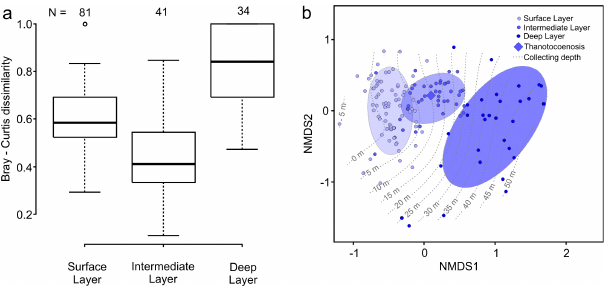
Fig. 4. (a) Quartile box plots of Bray–Curtis dissimilarities of the fossil and 156 recent gastropod assemblages. Assemblages from the Intermediate Layer habitats showed the significantly (F 2 , 153 = 52.44, P < 0 . 05) lowest pairwise Bray–Curtis dissimilarity to the fossils of core Co1200. (b) Three-dimensional NMDS plot of gas- tropod communities (Stress value 15.4). According to vector fitting, the thanatoecoenosis is well nested within the ellipse with one stan- dard deviation of the Intermediate Layer and the depth estimation equals 10m.